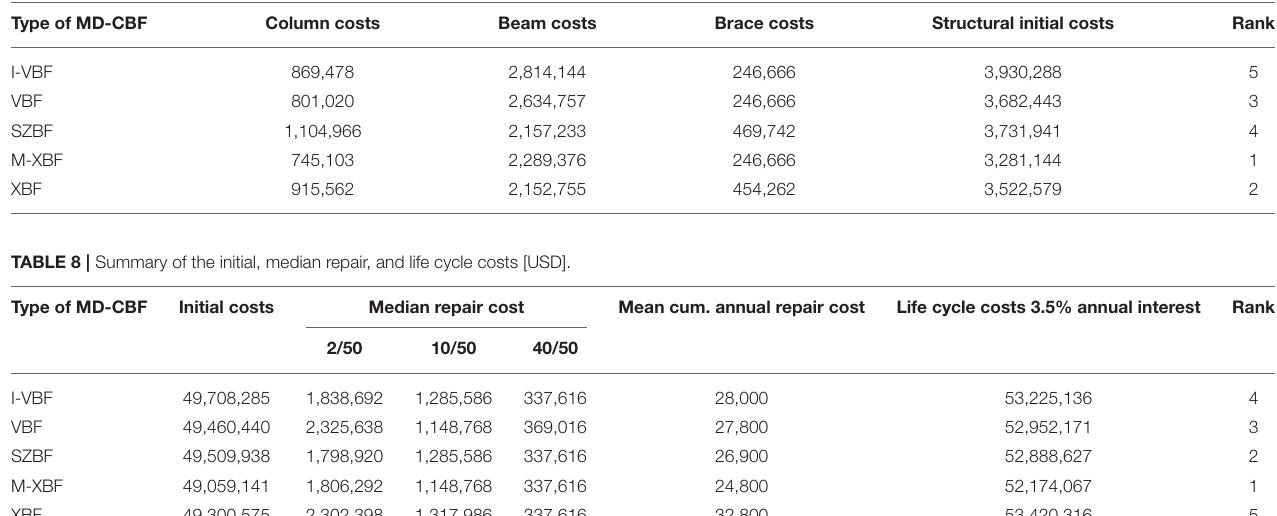
TABLE 7 | Summary of the structural elements cost [USD].